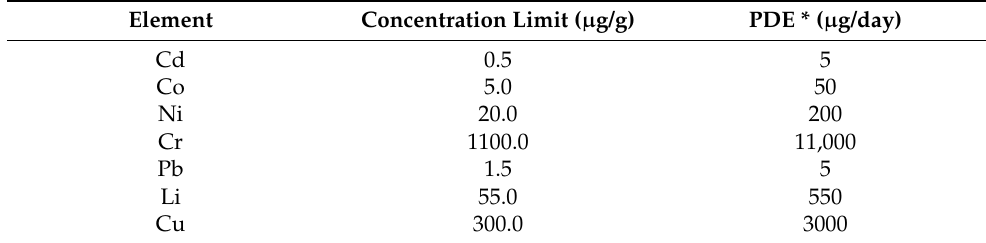
Table 4. Elemental impurity limits according to current EMA, WHO and USP guidelines.